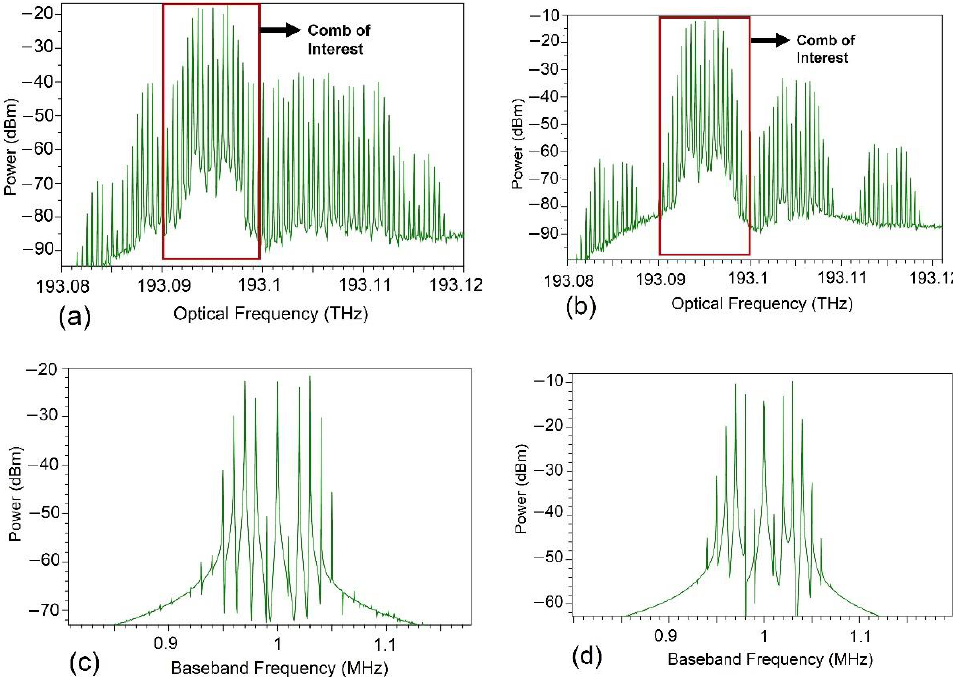
Figure 6. ( a ) Optical Dual-Comb with SE-MZM. ( b ) Optical Dual-Comb with DE-MZM. ( c ) Comb in IF frequency, centered at 1 MHz when operated with the SE-MZM approach. ( d ) Comb in IF frequency, centered at 1 MHz operated with the DE-MZM approach. Each one of the spurious sidebands obtained with DSB-SC modulation has a comb associated after they pass through the EOPM. In the case of DE-MZM, the combs are more separated than in the case of the SE-MZM. This means that all the mixing products are also far apart from the main set in the case of the DE-MZM approach. It can be observed that the DE-MZM structure offers an IF comb with more power (10 dB more than in the case of SE-MZM).